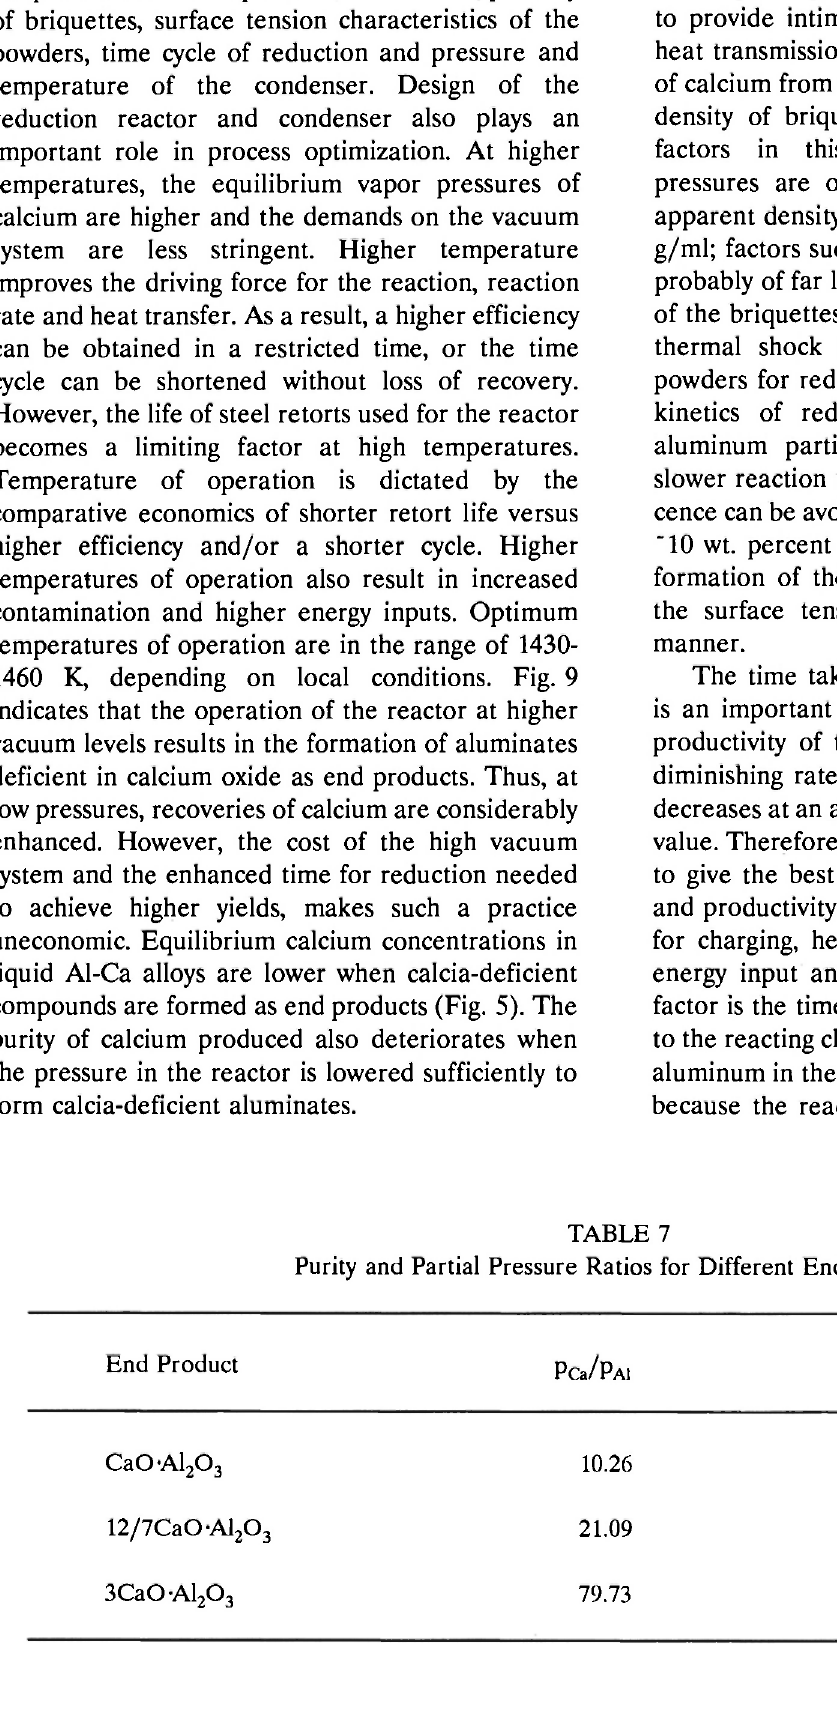
Purity and Partial Pressure Ratios for Different End